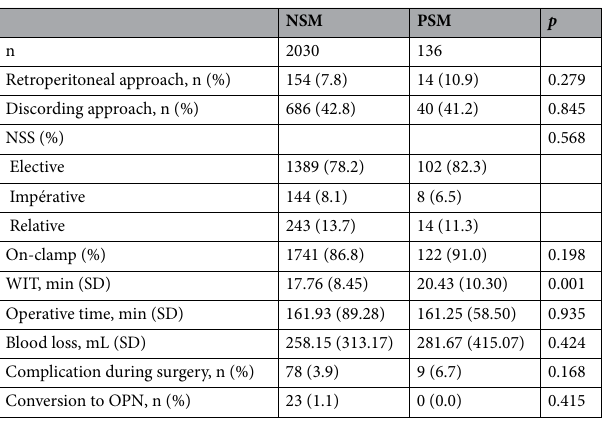
Table 2. Perioperative outcomes. NSM negative surgical margins, PSM positive surgical margins, NSS nephron sparing surgery, WIT warm ischemia time, OPN open partial